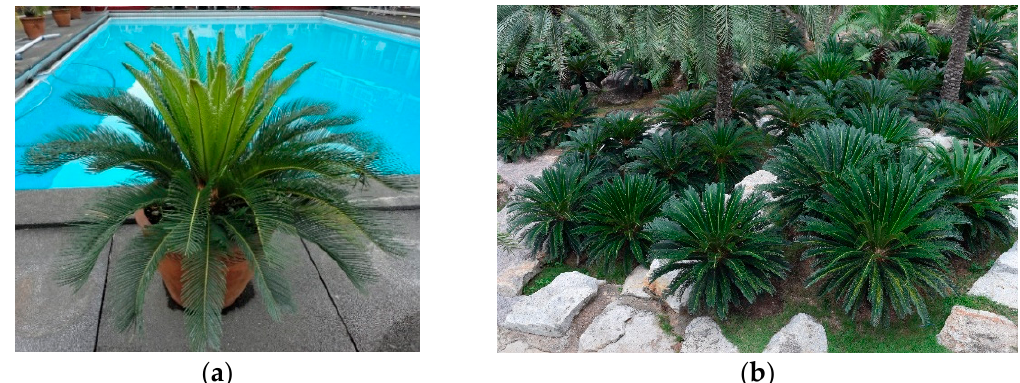
Figure 1. Cycas revoluta is shipped in high volumes to support the international horticulture industry. The species is used in numerous horticultural applications. ( a ) Containerized specimen plants are used as house plants, accent plants in the landscape, and bonsai. ( b ) Mass plantings of C. revoluta provide stunning landscapes.